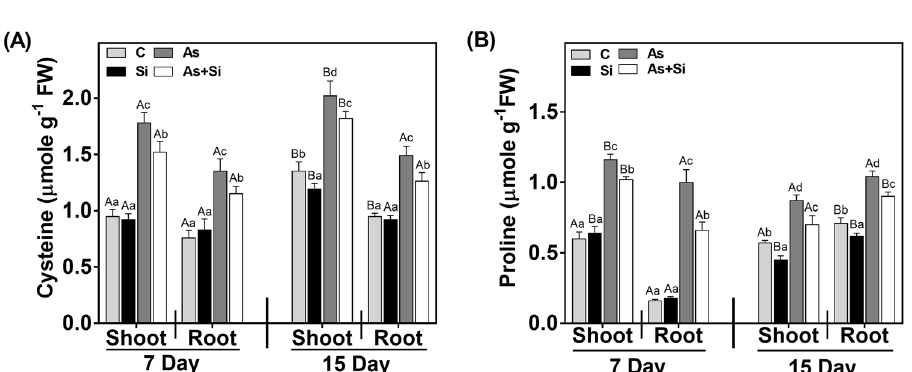
Figure 8. Effect of Si supplementation on ( A ) APX ( B ) MDHAR, and ( C ) GR activity in shoot and roots of Oryza sativa var. IR64 at 7 and 15 d under As (III) stress. All values are means of three replicates (n = 3, ± SD) and repeated twice. Different letters indicate the significant mean difference ( p < 0.05) between each treatment. The small latter (i.e. a, b, c and d) indicates the significant difference between treatment in same tissue type while capital latter (i.e. A and B) indicates the significant difference between duration among the same treatment in same tissue type.